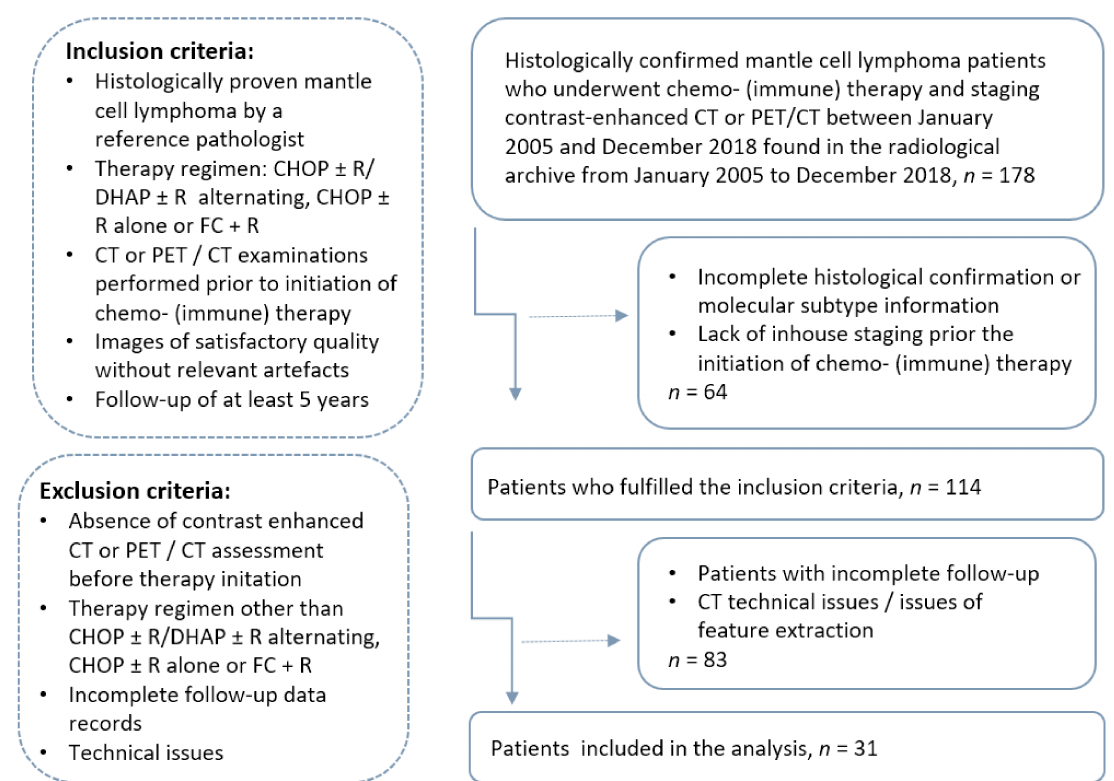
Figure 1. Recruitment pathway of the